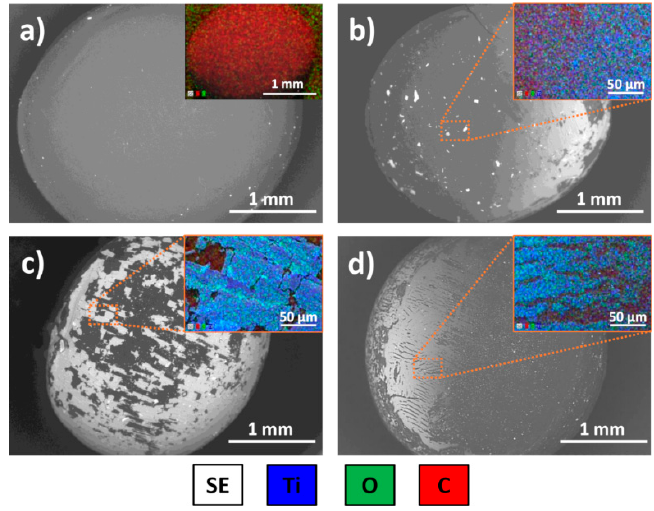
Figure 2. SEM view images and elemental mapping results: ( a ) primary HDPE bead; ( b ) HDPE + TiO 2 ; ( c ) HDPE + TiO 2 after 5th run of MB decomposition; ( d ) HDPE + TiO 2 after 5th run of Salmonella Typhimurium SL1344 bacterial inactivation.